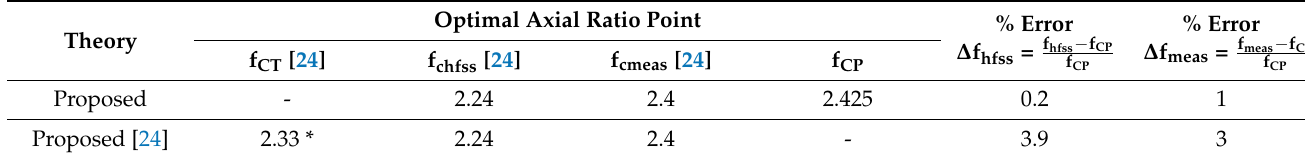
Table 4. Experimental validation of the proposed theory for calculation of the optimal axial ratio point of a circularly polarized hollow RDRA having dimensions l 0 = 21.7, w 0 = 57.5, h 0 = 46, l p = 11.8, w p = 48.2, and h p = 31.8, with a dielectric constant ε r = 9.4, ε p = ε 0